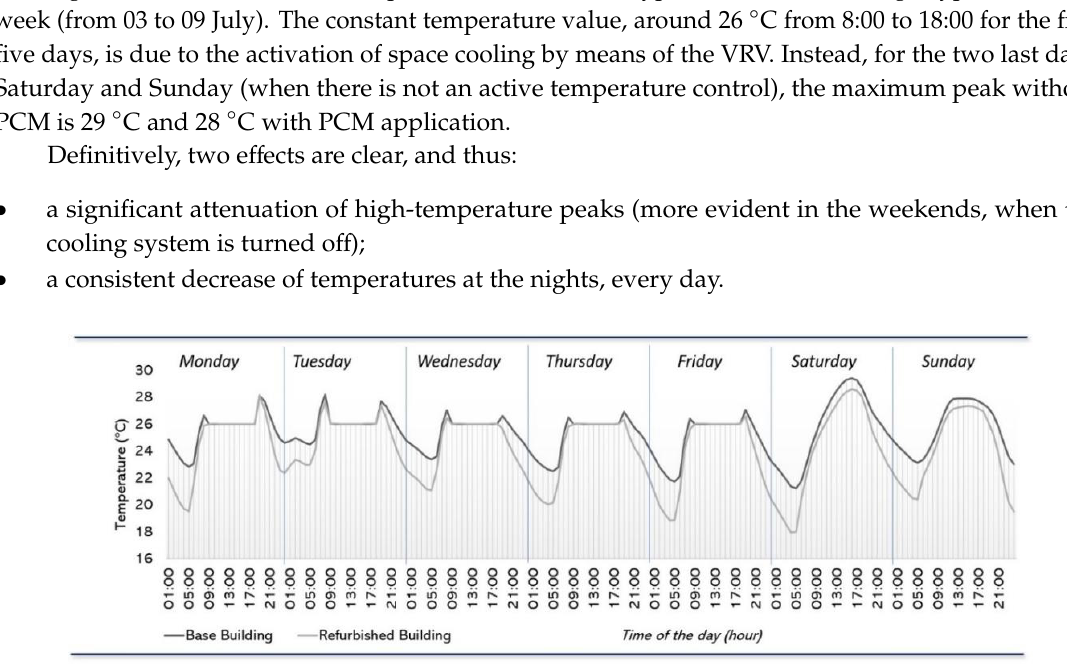
Figure 13. Curves of indoor temperature.